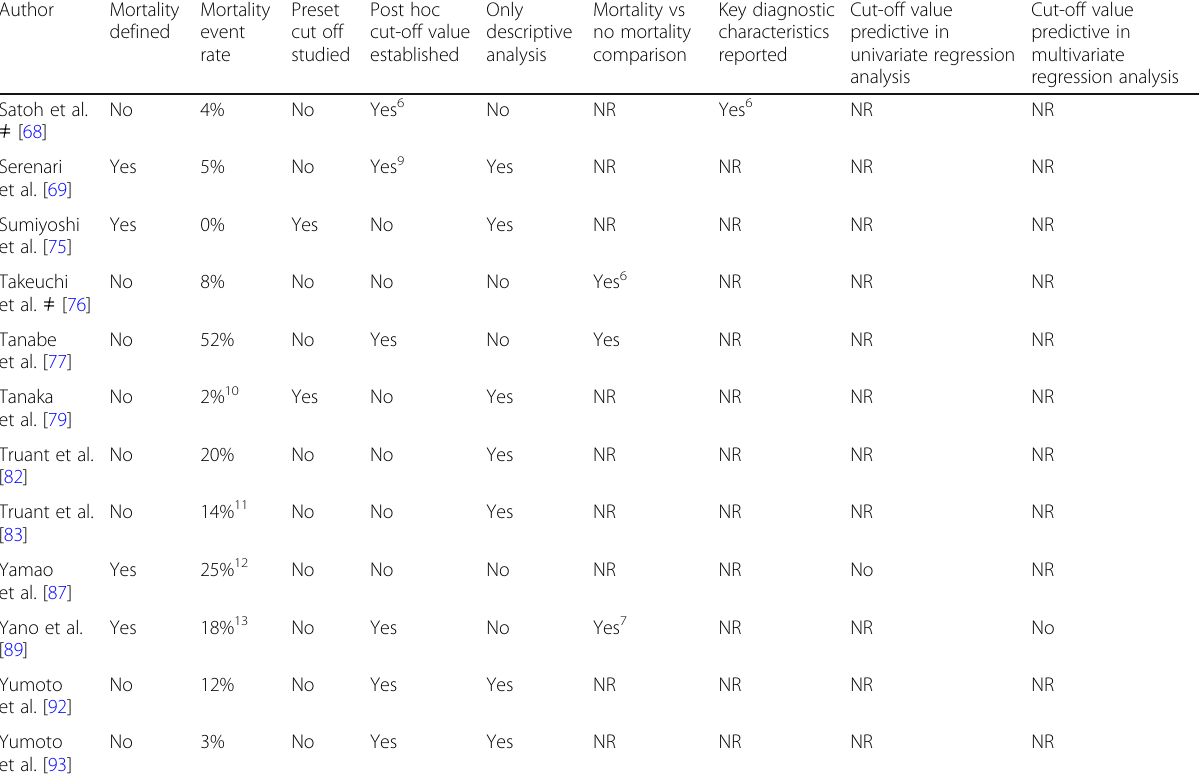
Table 2 Overview of trials reporting on the correlation between a preoperative nuclear imaging examination and postoperative mortality